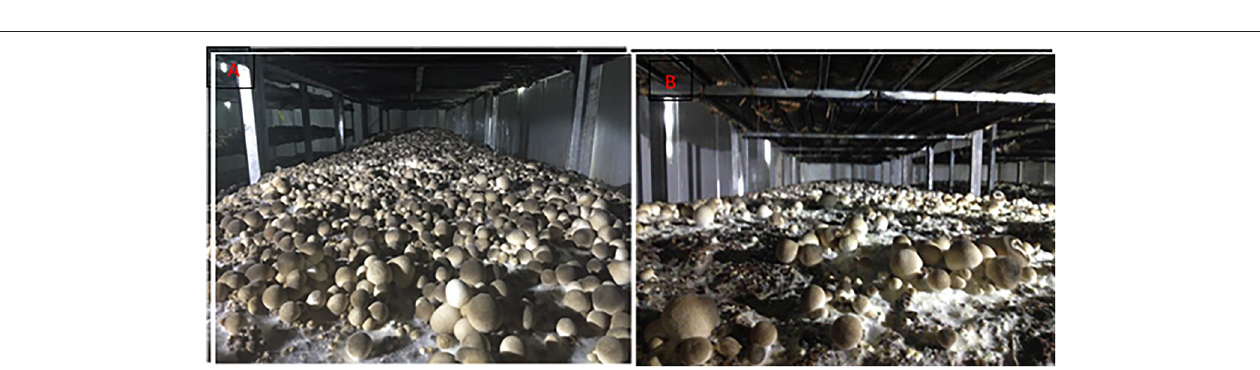
FIGURE 3 | Effects of 0.08% NaAc sprayed at the substrate mixing stage on the fruiting body of V. volvacea . (A) The fruiting body after application of NaAc. (B) The fruiting body of the control.